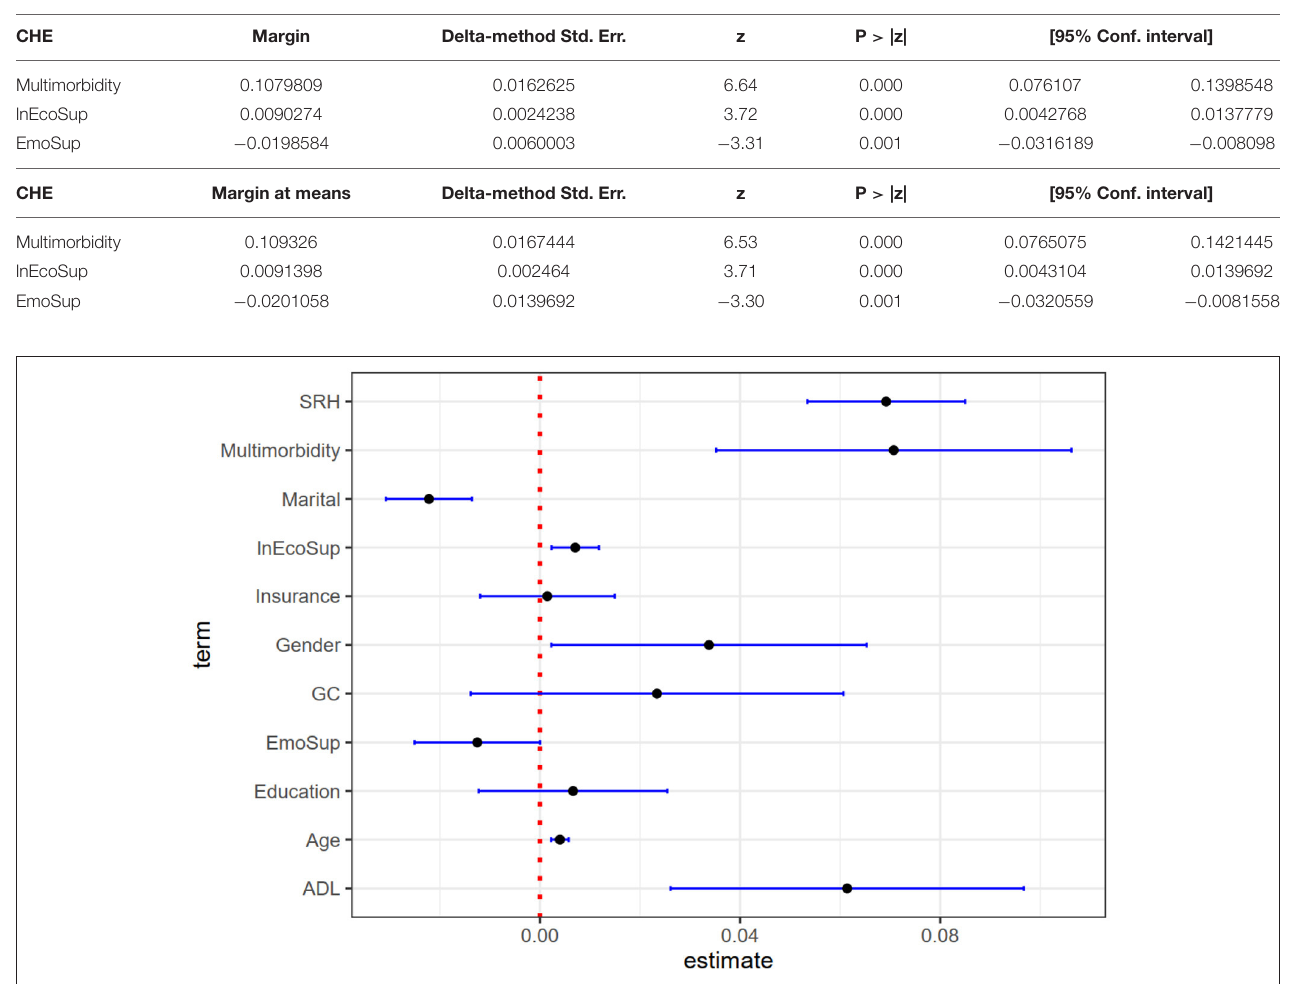
FIGURE 3 | Visualization of logistic regression